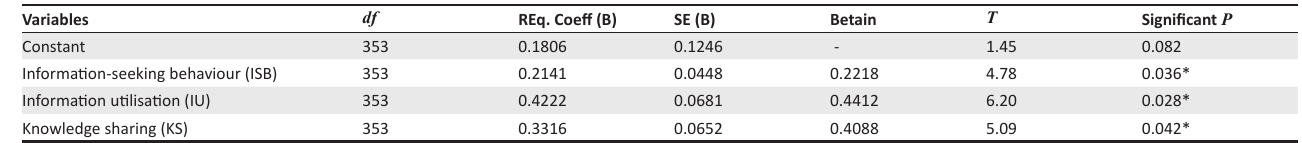
TABLE 7: Summary of test of significance of independent variables to the prediction of innovation capability of the respondents. Variables df REq. Coeff (B)